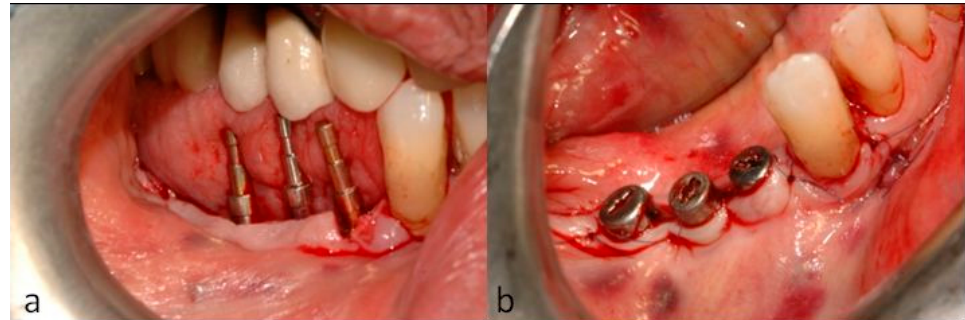
Figure 11. ( a ) The parallelism of the implants was confirmed, and ( b ) the soft tissue was sutured around the healing abutments.